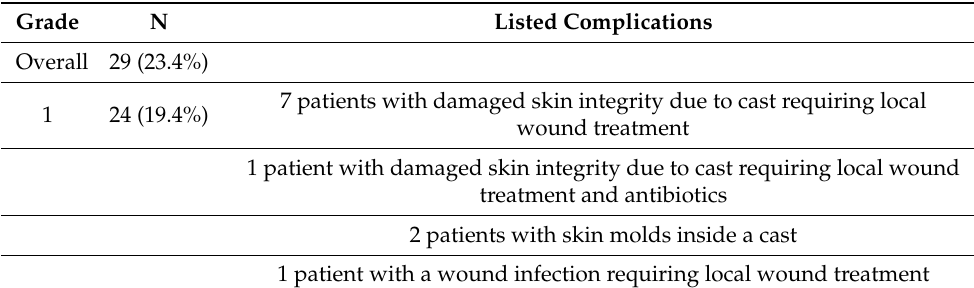
Figure 4. Scatter plots of pre- and postoperative differences of the tibiofemoral angle measured on radiographs and photographs. ( A ) Anatomical tibiofemoral angle and photographs. ( B ) Mechanical tibiofemoral angle and photographs. Table 5. List of complications according to the classification of